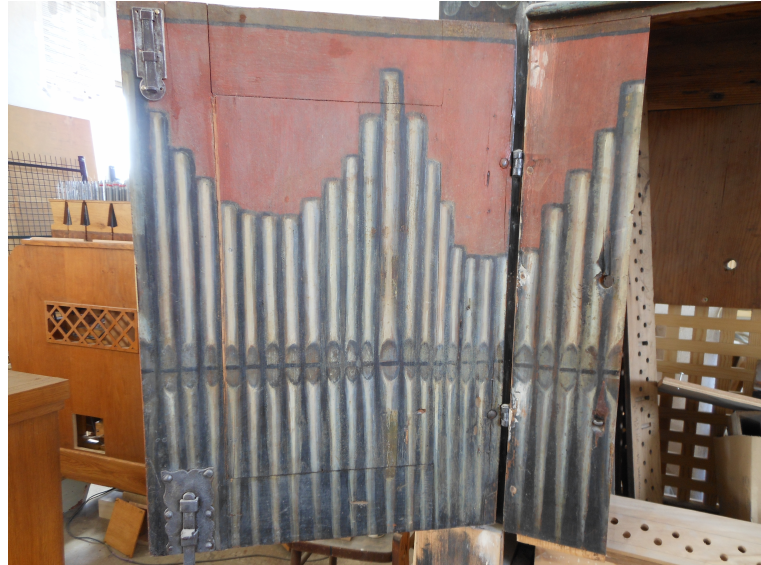
Figure 3. Chest organ left wing.